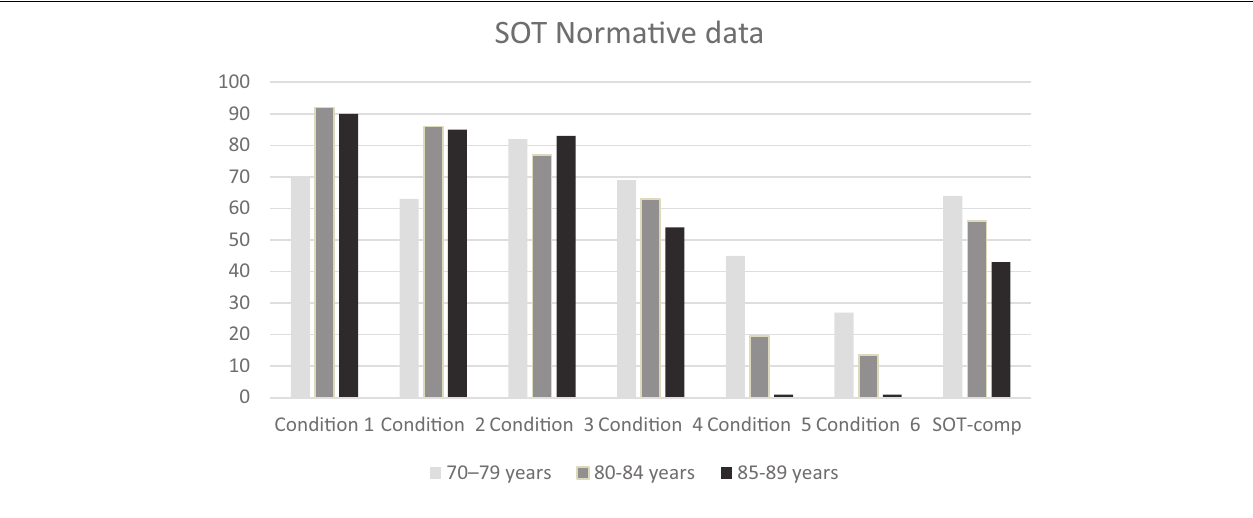
FIGURE 3 | Normative data for the six conditions and for the composite Sensory Organization Test data in the three age groups considered in this study. The striking reduction in norm values in conditions 5 and 6 is due to the wide standard deviation in those conditions. Data for the 70–79 age group are provided by NeuroCom R (cid:13) International Inc. (2003).